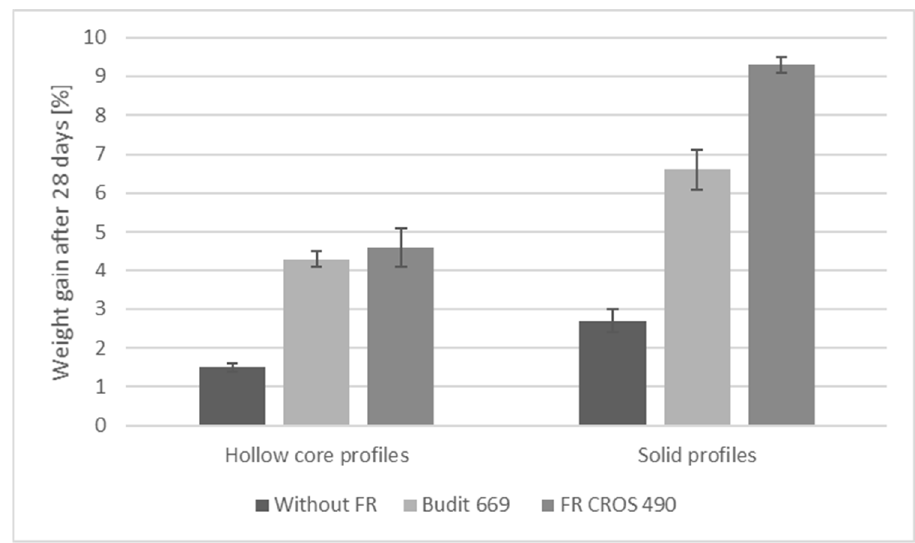
Figure 13. Swelling of co-extruded solid profiles after 28 days storage in cold water. Requirements according to Table 7 were fulfilled.